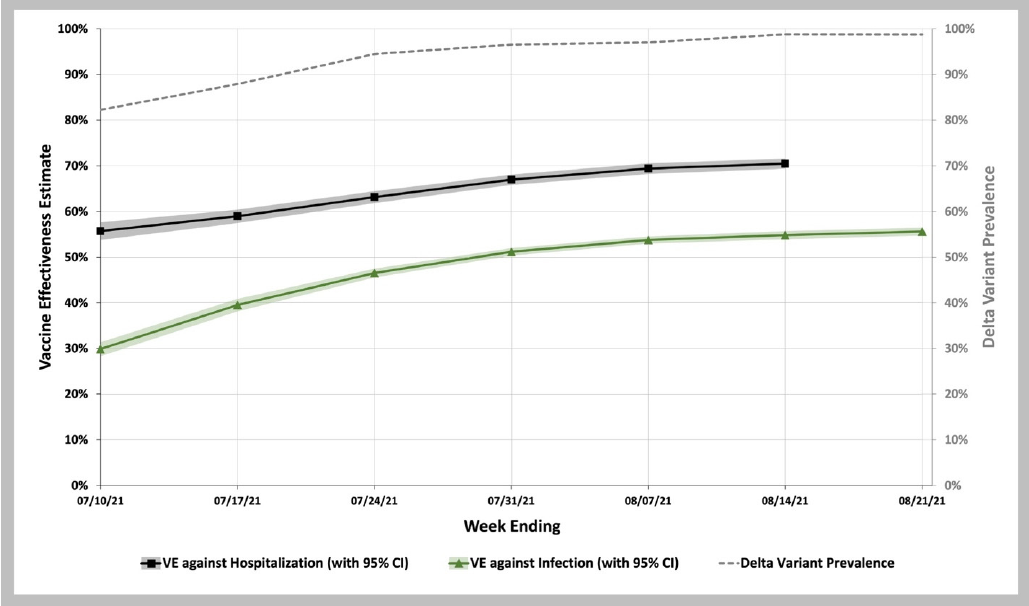
Figure 2. COVID-19 Vaccine Effectiveness against Infection and Hospitalization during the Delta Variant Phase of the Pandemic. Vaccine effectiveness estimates against infection (green curve with 95% CI shown in green shaded area) and against hospitalization (black curve with 95% CI shown in gray shaded area). Weekly SARS-CoV-2 Delta variant prevalence reported by the CDC (gray dashed line).